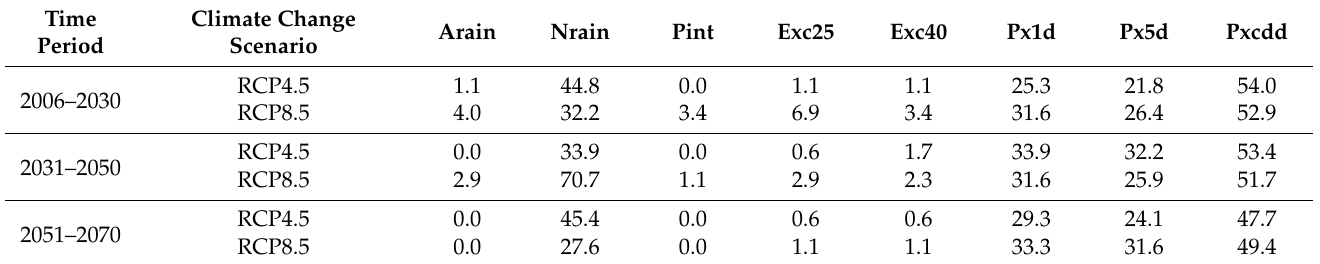
Figure 6. Spatial distribution of annual percentage changes of Px1d across the Beijing-Tianjin-Hebei region during 2006–2030, 2031–2050, and 2051–2070 compared with 1961–2005. Table 5. The percentages of stations with negative changes in the eight precipitation indices during the future three periods in the Beijing-Tianjin-Hebei region (unit: %).